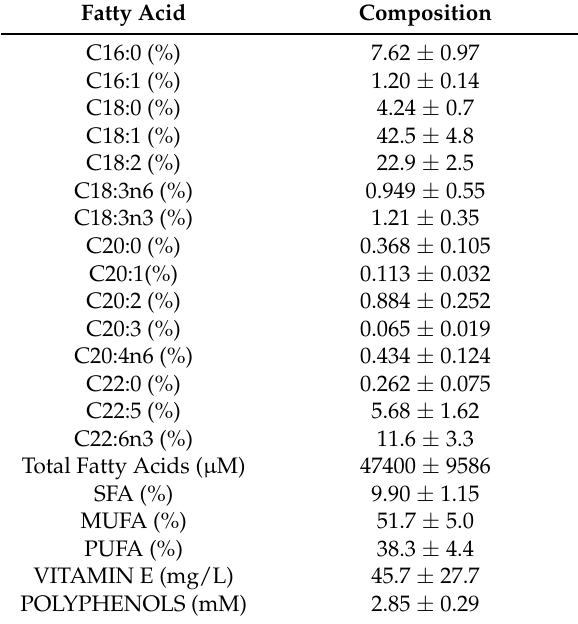
Table 2. Beverage fatty acid composition.